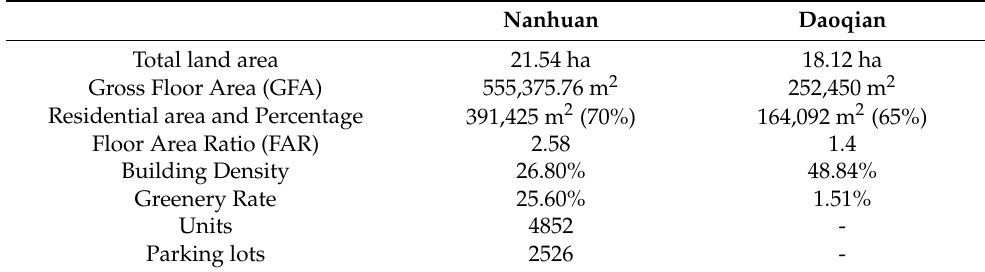
Table 2. Community construction